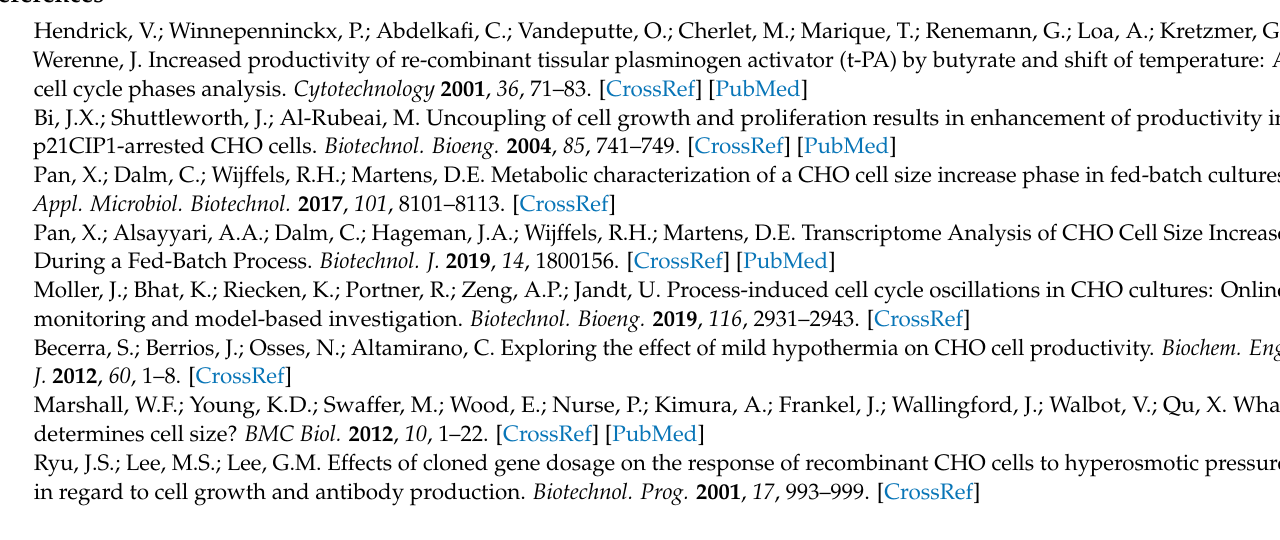
Figure A3. Forward scatter height versus area for single cells on days 2 and 14 from the bioreactor run at physiological temperature.